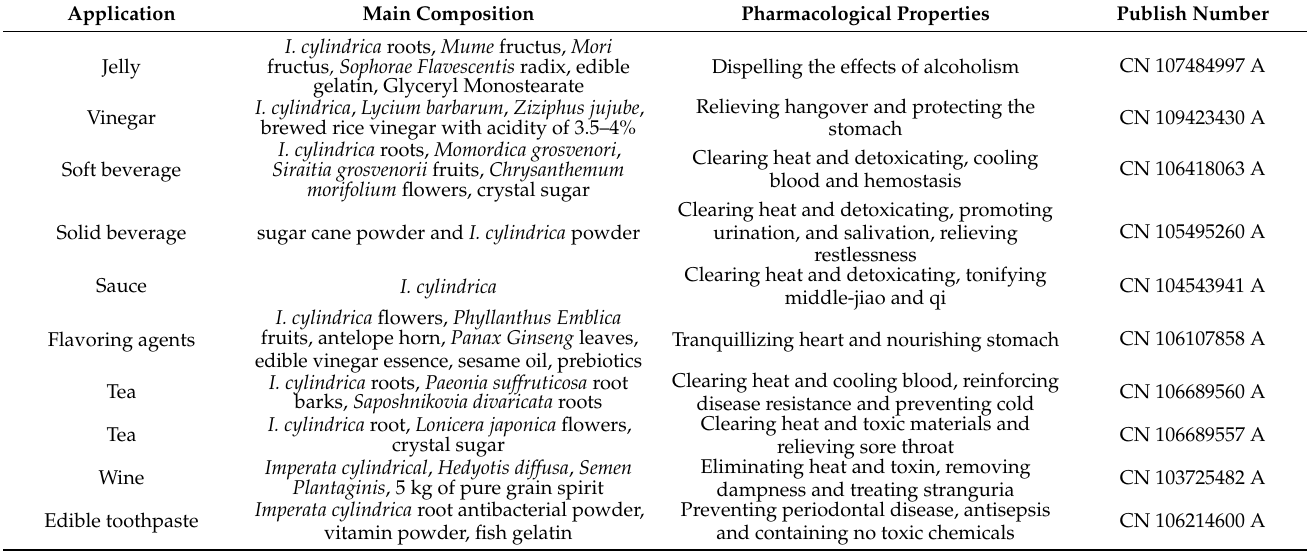
Table 2. Patents list of products containing constituents from I. cylindrical and their claimed pharmacological